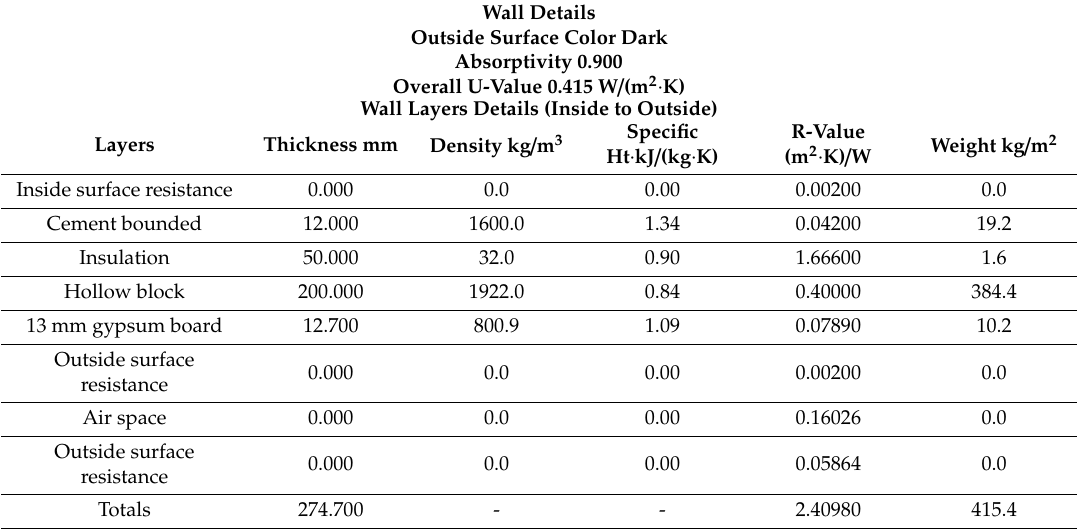
Table A1. Wall layers